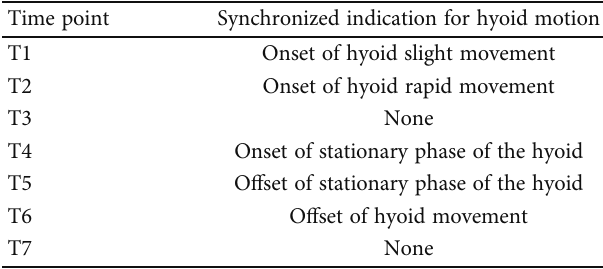
Table 1: De fi nitions of time points on the laryngeal signal waveform recorded by the bend